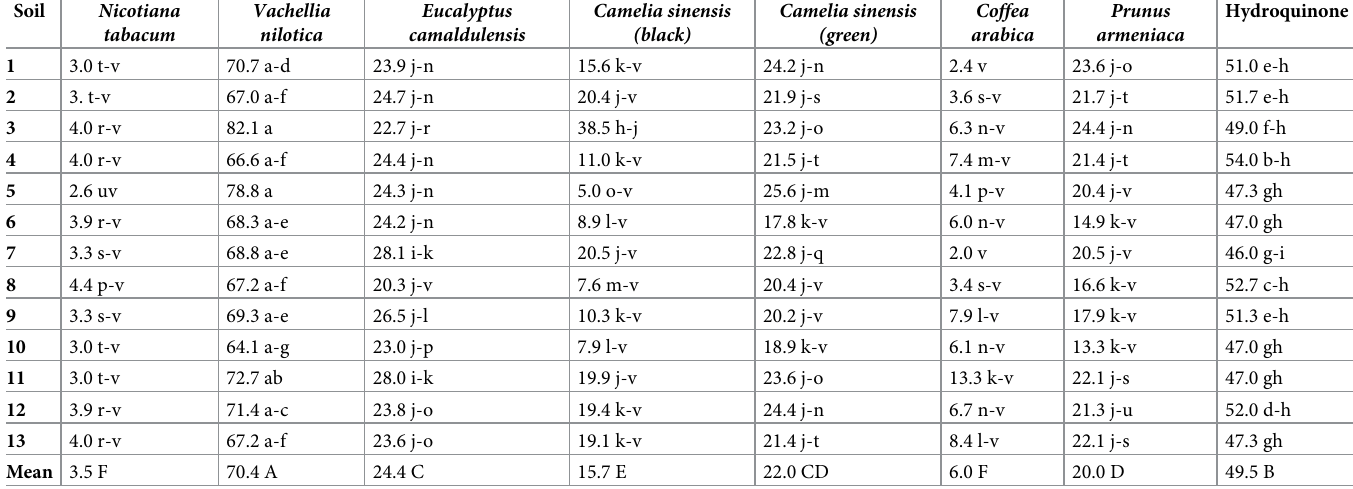
Table 3. Urea hydrolysis inhibition in thirteen soils estimated in an In-vitro assay involving an incubation of soil with urea at 37˚C for two hours. Soil